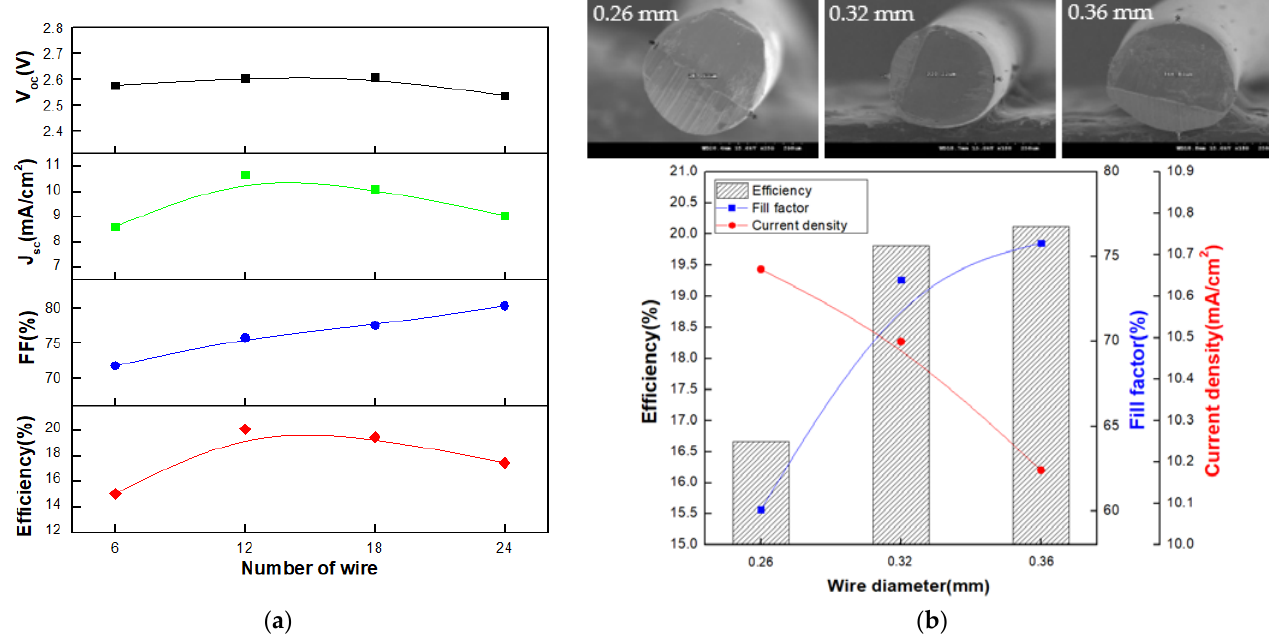
Figure 10. Characteristics of a 2 × 2-unit module based on the number of wires ( a ) and wire diameter ( b ), and SEM im-ages of wires with diameter of 0.26 mm, 0.32 mm, 0.36